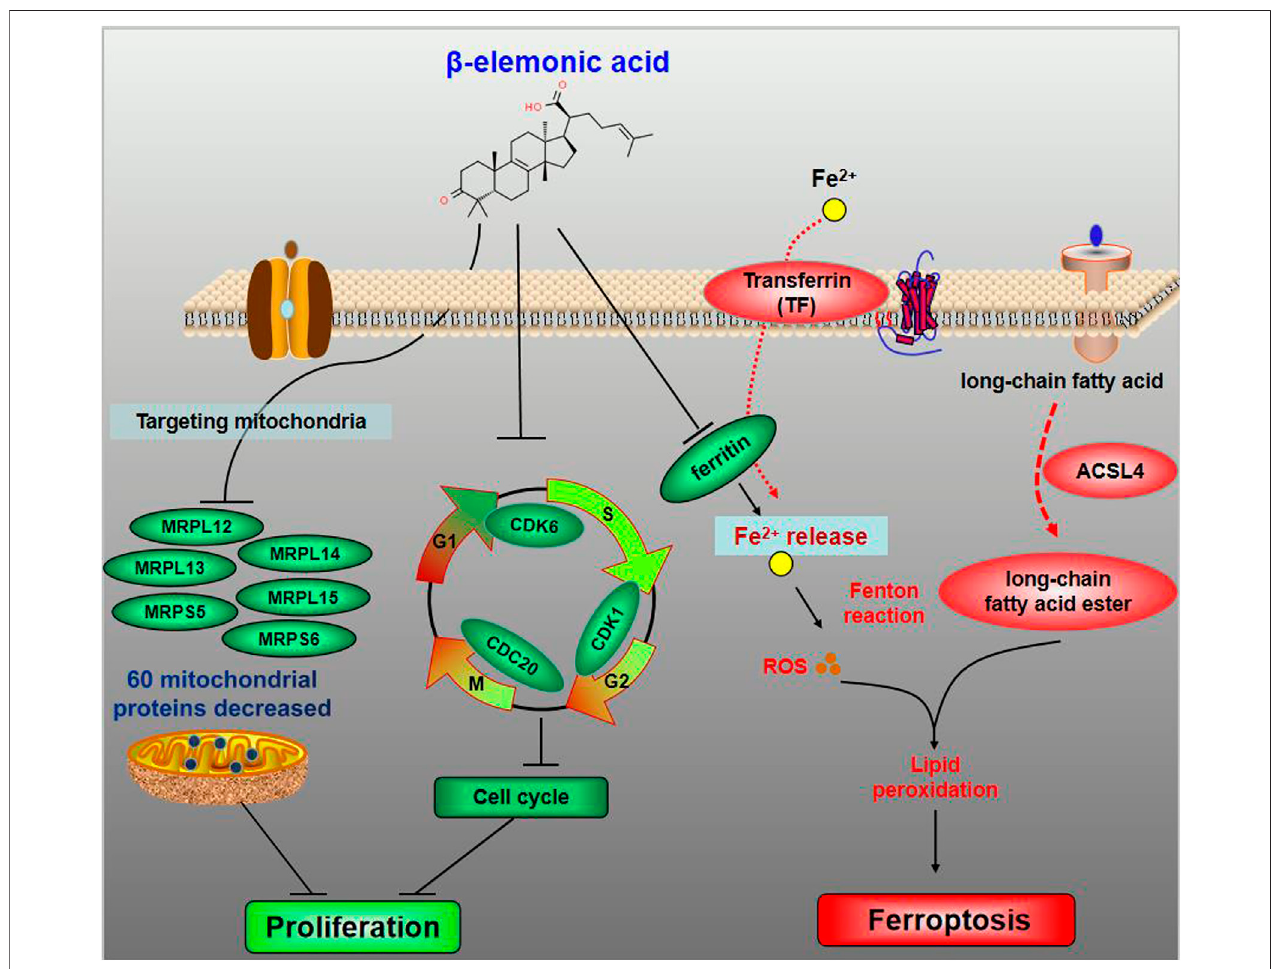
FIGURE 7 | The schematic diagram for the molecular pharmacological mechanism of EA suppressing colorectal cancer. The dominant target organelle of EA for colorectal cancer is mitochondria. EA can reduce 60 mitochondrial proteins, among which more than 90% are mitochondrial ribosomal proteins. Moreover, based on what we discovered, the anticancer mechanism of EA could be described as follows: at low concentration, EA inhibited the cell cycle by downregulating CDK1, CDK6 and CDC20; at high concentrations, EA induced ferroptosis by upregulation of TF, CP and ACSL4, and down-regulation of FTL.